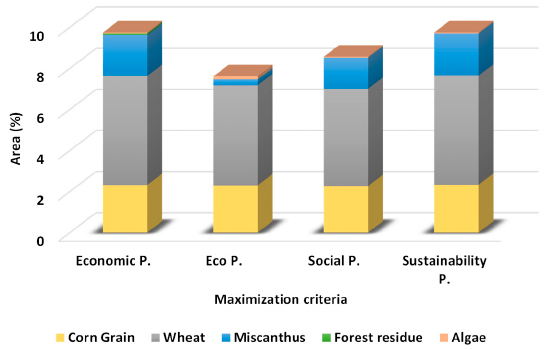
Figure 4. Usage of available area when maximizing different profits.